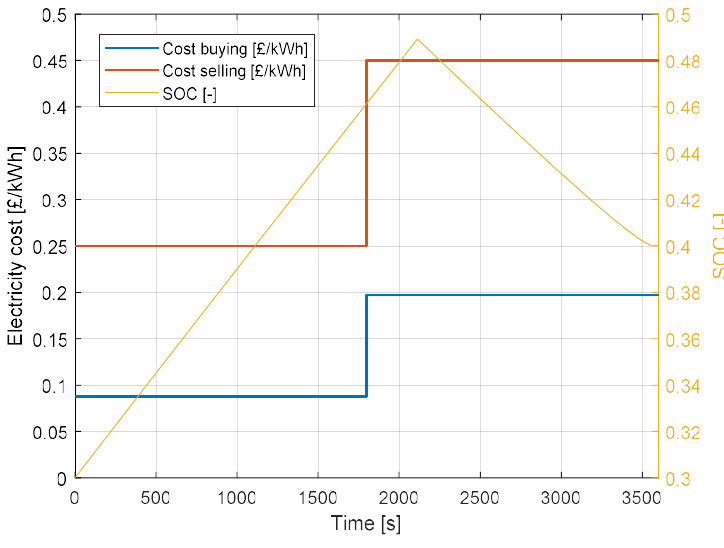
Figure 13. Electricity cost and State-of-Charge (SOC) for scenario 5.